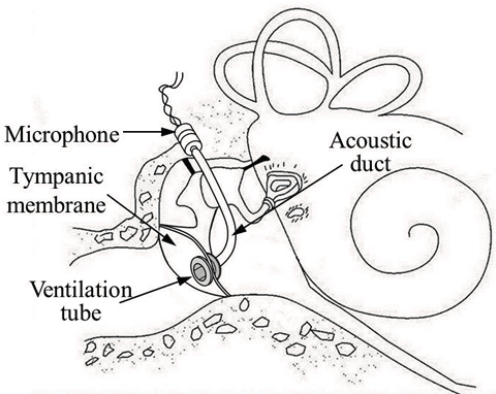
Figure 2. Conceptual diagram of the proposed trans-tympanic implantable